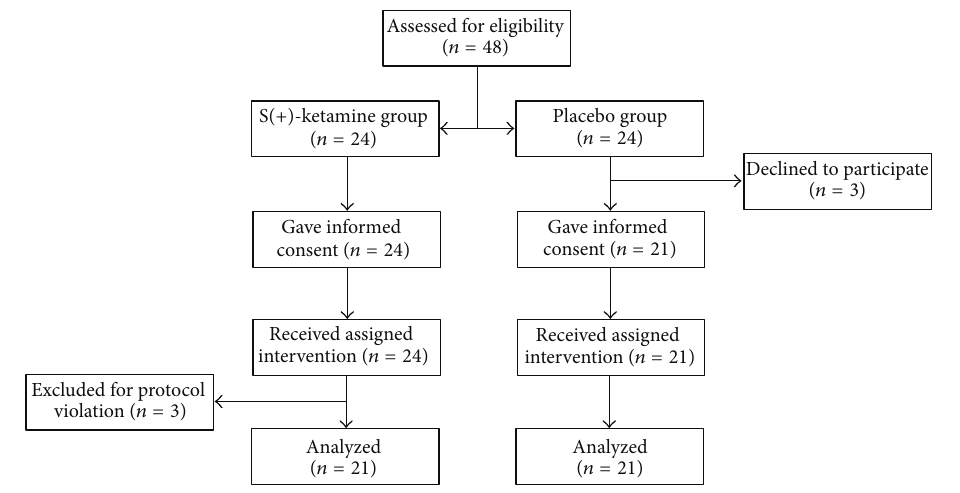
Figure 1: Patient flow chart.